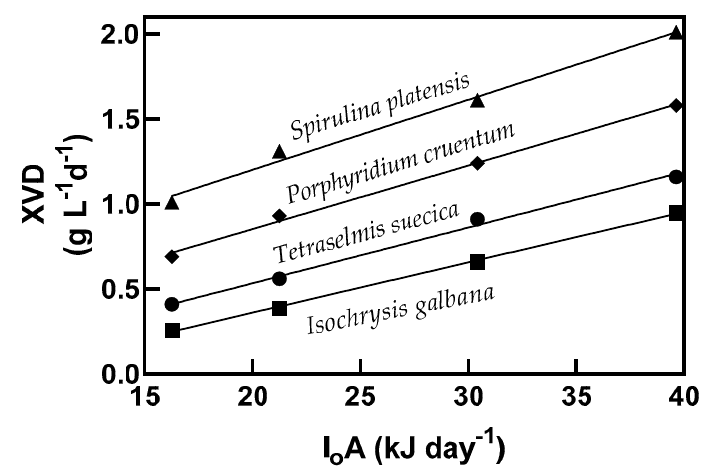
Figure 2. The biomass produced in steady state condition at D (dilution rate) = 0.6 d − 1 for each energy supplied in continuous cultures of S. platensis , P. cruentum , T. suecica , and I. galbana.